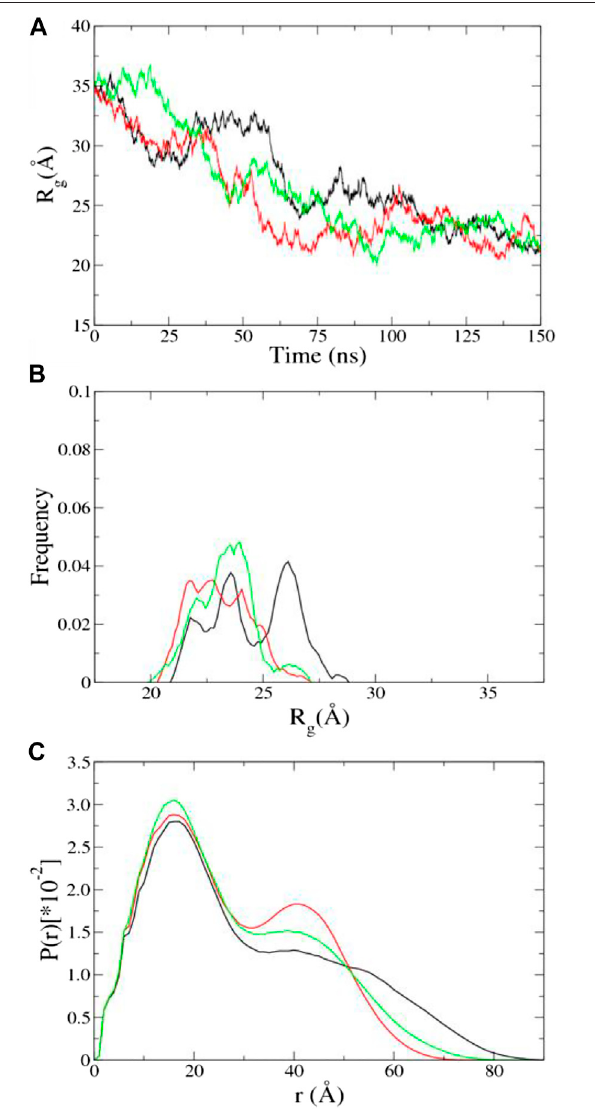
FIGURE4| ResultsofaMDusingA99SB/OPC. (A) TimeevolutionofR g . (B) R g distribution in the last 80 ns aMD simulations. (C) Ensemble-averaged PDDF in the last 80 ns aMD simulations. The three independent simulations are shown in different